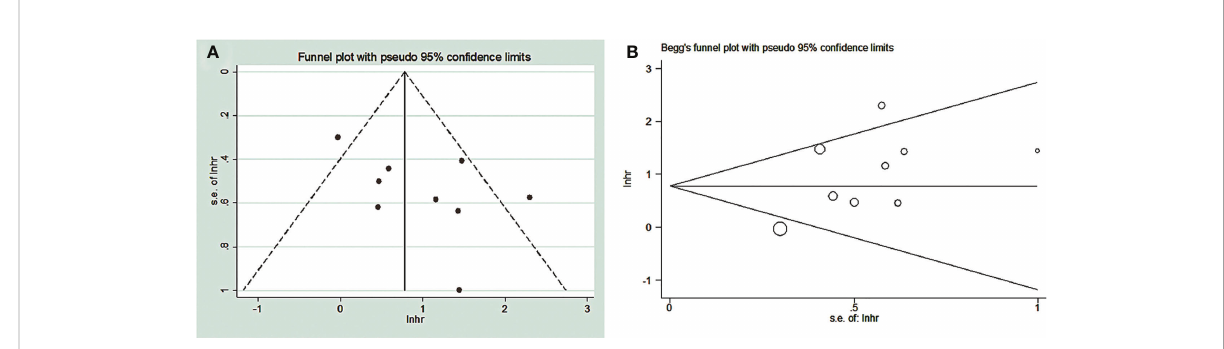
FIGURE 7 Publication bias between TDO2 and OS in patients with malignant tumors. (A) Funnel plots; (B) Begg ’ s test. TDO2, tryptophan 2,3-dioxygenase.